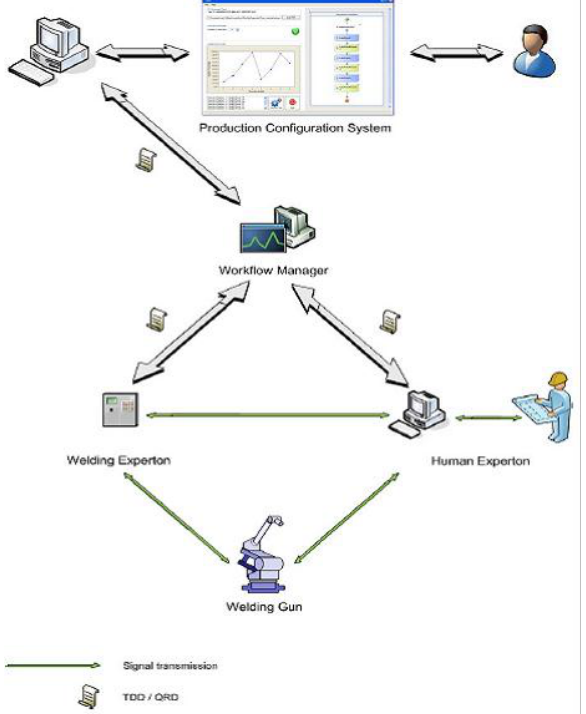
Figure 6. Production Execution System diagram